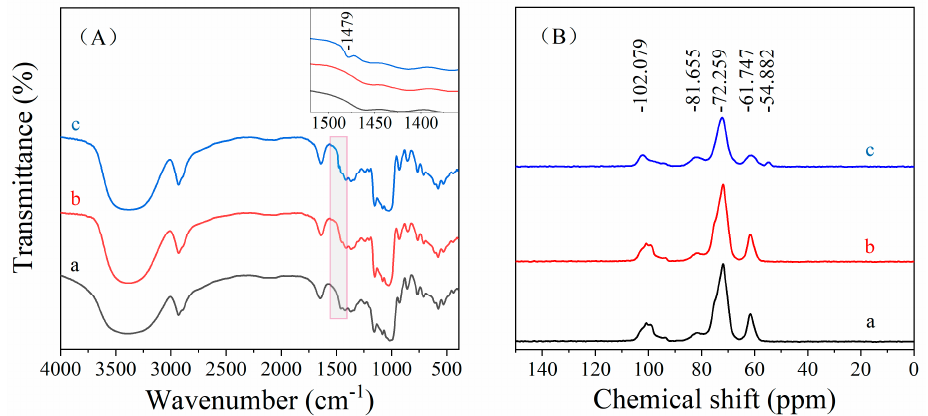
Figure 2. FTIR spectra ( A ) and 13 C NMR spectra ( B ) of (a) native cassava starch, (b) acid-treated cassava starch, and (c) CA ‐ CSNPs. The inset of ( A ) is a partial enlargement of (a, b, and c).